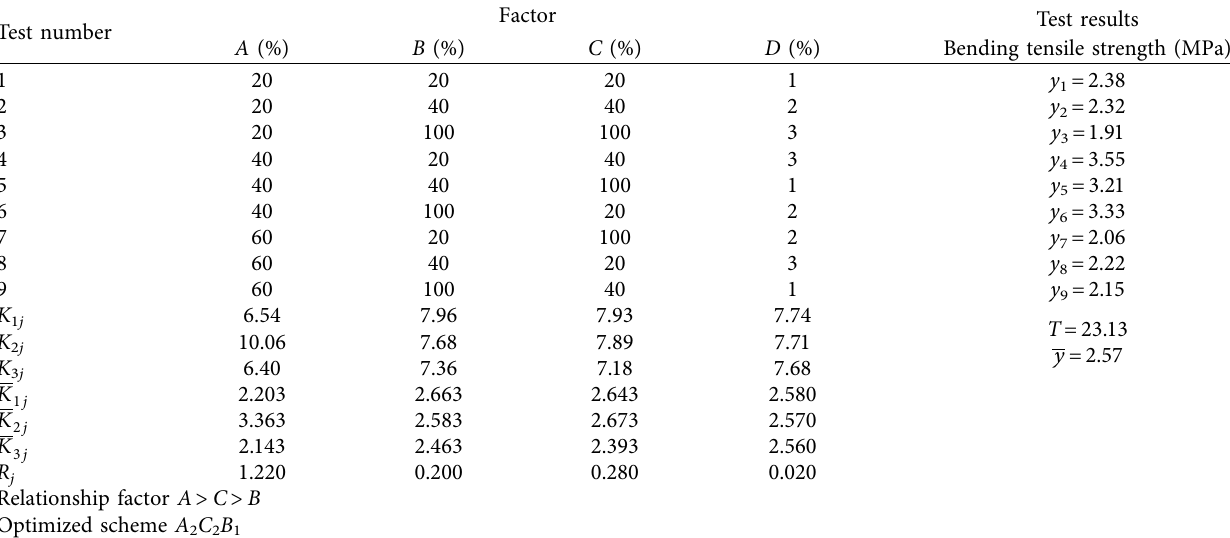
Table 4: Test results and calculation analysis.